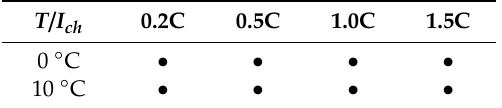
Table 2. Test matrix for load cyclization, whereby “ • ” stands for tested with two cell